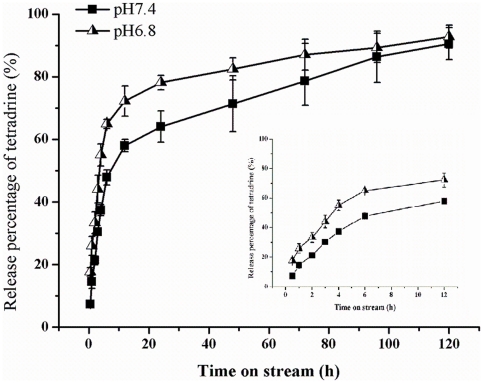
In vitro release profile of Tet from the NPs at different pH values.The data were presented as Mean±SD. Where bars are not shown, SD is less than the height of the points. The figure at the right shows the release profile at the first 12 h as it is not very clear at the original figure.